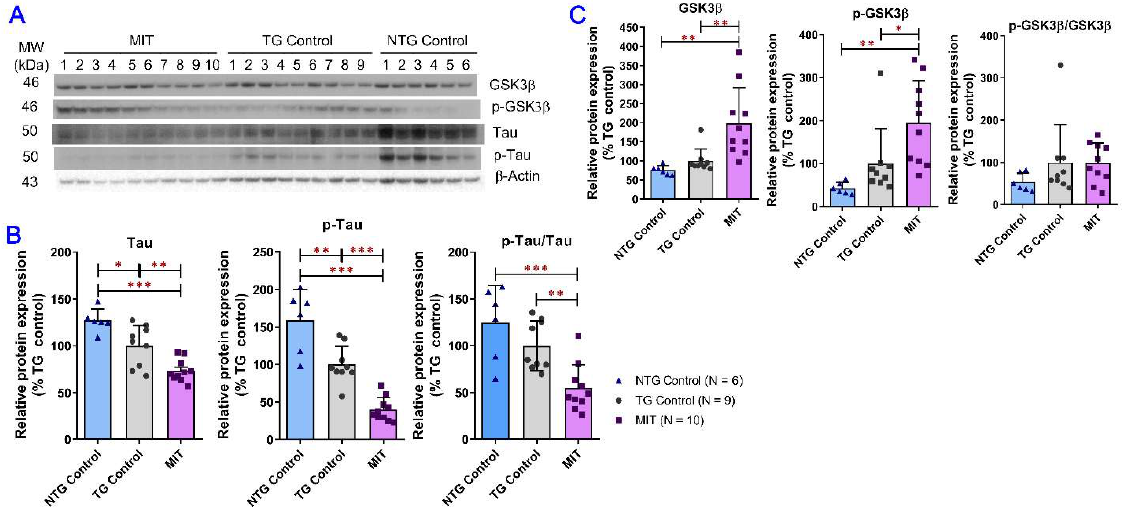
Figure 3. Evaluation of total and phosphorylated tau and GSK3β expression in brain tissues using the semi-quantitative Western blot analysis. ( A ) Representative immunoblots demonstrating the expression of tau, phospho-tau (p-tau), GSK3β, and phospho-GSK3β (Ser9) (p-GSK3β) proteins in brain tissues collected from individual mice. ( B , C ) Densitometric analysis of the relative protein expression levels of tau, p-tau, GSK3β, and p-GSK3β in the brain tissues collected from individual mice. MIT treatment significantly decreased the expression of tau and p-tau as well as the phosphorylated-to-total tau ratio compared with the vehicle control treatment in NTG ( p < 0.001 for all) and TG ( p < 0.01 for tau and phosphorylated-to-total tau ratio; p < 0.001 for p-tau) mice. MIT treatment significantly increased the expression of GSK3β and p-GSK3β compared with the vehicle control treatment in NTG ( p < 0.01 for both) and TG ( p < 0.01 for GSK3β; p < 0.05 for p-GSK3β) mice but had no significant effect on the phosphorylated-to-total GSK3β ratio. Data are presented as mean ± SD (N = 6 for the NTG control group, N = 9 for the TG control group, and N = 10 for the TG MIT treatment group). * p < 0.05, ** p < 0.01, and *** p < 0.001 compared between NTG control, TG control, and TG MIT treatment groups using the one-way ANOVA followed by a Tukey’s post hoc multiple comparison test.